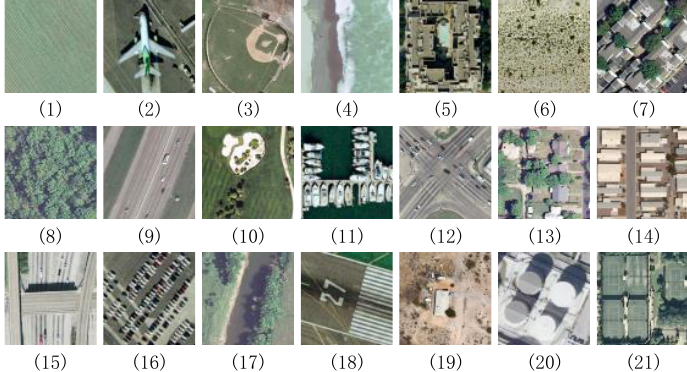
Figure 8. Class representatives of the UC-Merced dataset: (1) Agricultural; (2) Airplane; (3) Baseball diamond; (4) Beach; (5) Buildings; (6) Chaparral; (7) Dense residential; (8) Forest; (9) Freeway; (10) Golf course; (11) Harbor; (12) Intersection; (13) Medium residential; (14) Mobile home park; (15) Overpass; (16) Parking lot; (17) River; (18) Runway; (19) Sparse residential; (20) Storage tanks; (21) Tennis